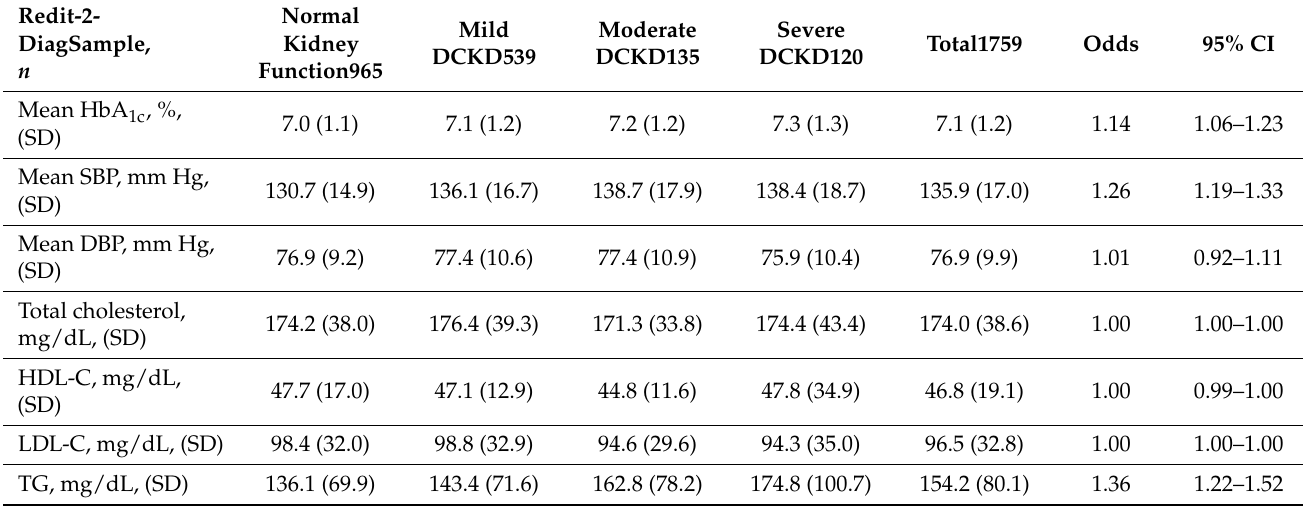
Table 1. Disease characteristics. Two-group analysis (normal kidney function vs. DCKD). Values are presented as a mean ± standard deviation (SD). DCKD: Diabetic Chronic Kidney Disease,